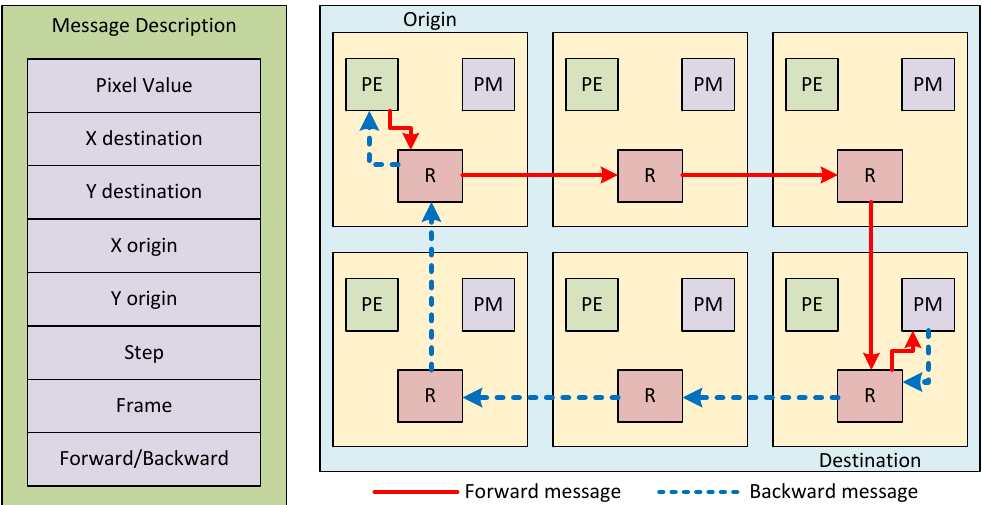
Figure 7. Message description and